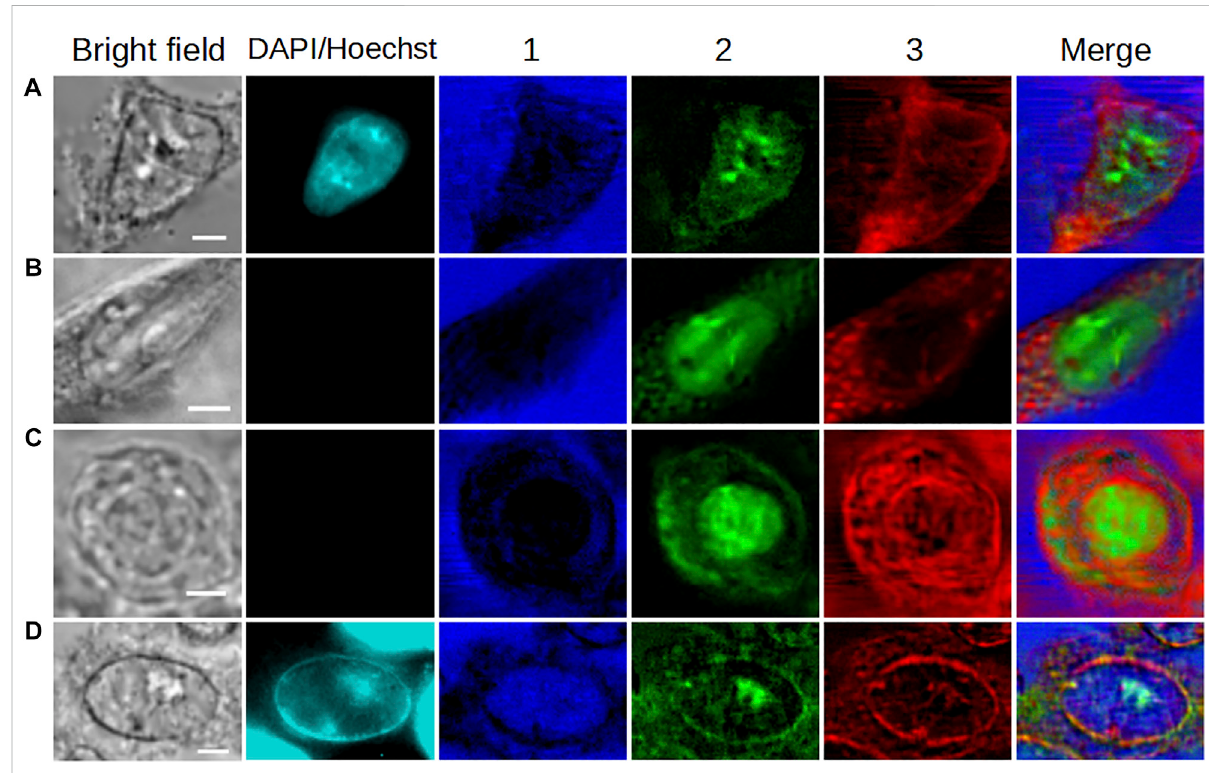
FIGURE 6 Overview of the application of the MC 2 approach to single-cell imaging in different cases. (A,B) Fixed interphase cells. (C) Fixed mitotic cell. (D) Livinginterphasecell.Imagesin1,2,and3aretheconcentrationmapsofcomponents#1,#2,and#3extractedfromFigures2A,3,4,5B,respectively, and plotted in false blue/green/red colors. The scale bar corresponds to 5 μ